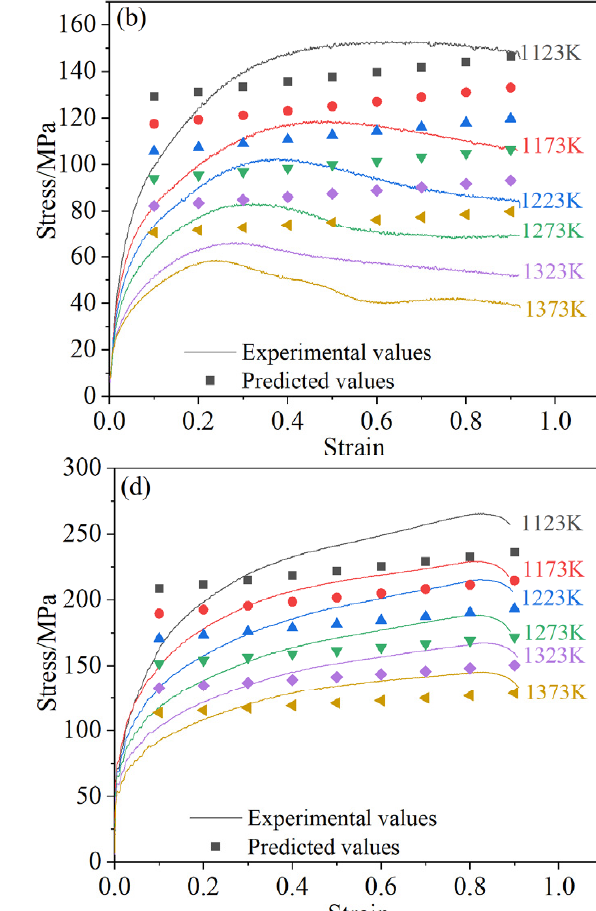
Table 2. Parameters for the Johnson–Cook model.